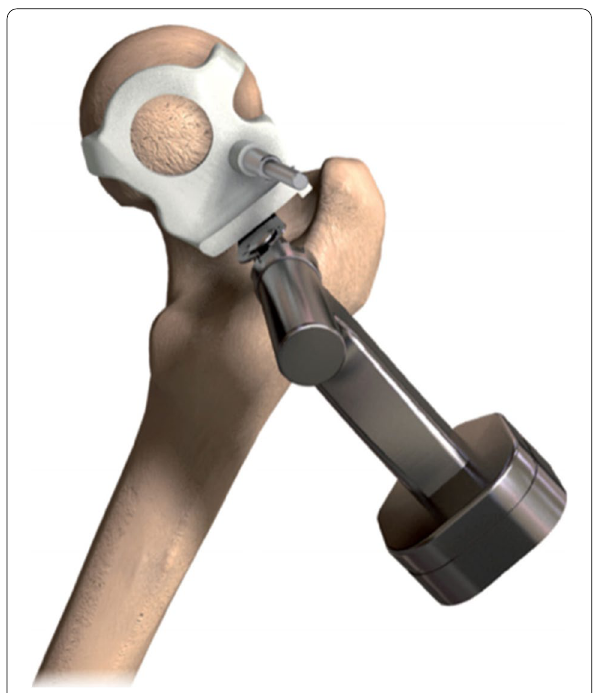
Fig. 1 Femoral neck osteotomy cutting guide